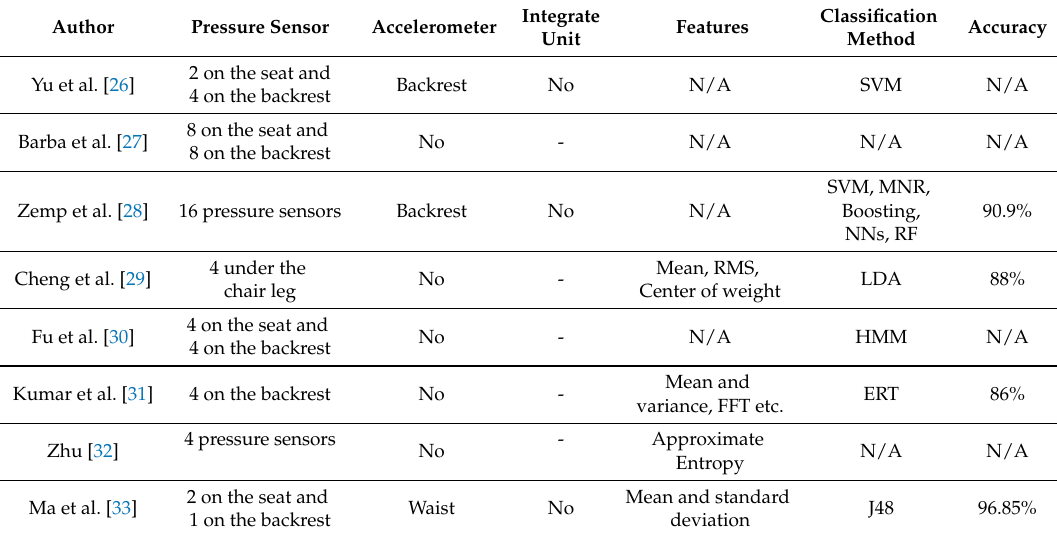
Table 1. Related works on cushion based